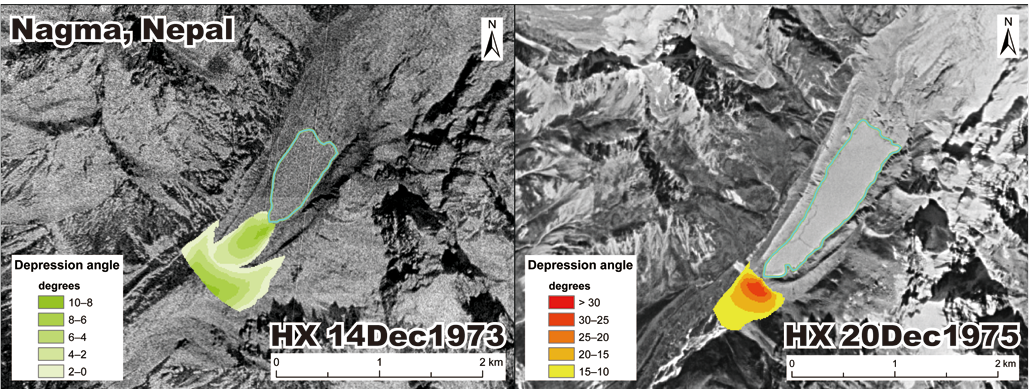
Fig. 11. Evolution of steep lakefront area associated with downstream lake expansion of the Nagma Pokhari, Nepal between December 1973 (left, PFV = 0) and December 1975 (right, PFV = 32.8 million m 3 ) . Both images and digital elevation models are based on Hexagon KH-9 imagery.